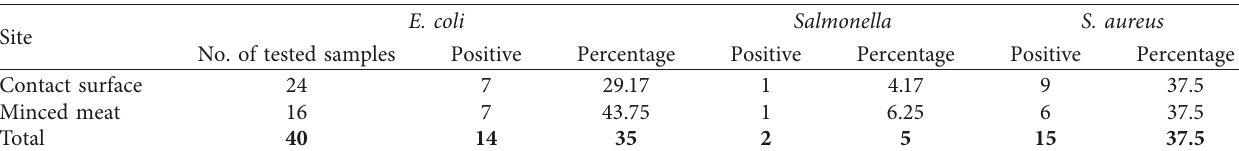
Table 5: Frequency distribution of suspected pathogenic bacteria of meat and contact surface samples. E. coli Salmonella S. Site